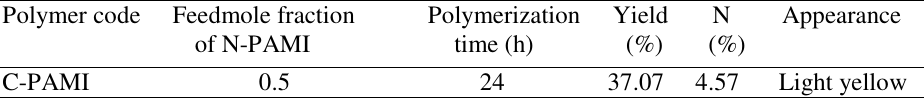
Table 1. Radical copolymerization of N-PAMI and MMA in THF at 65˚C